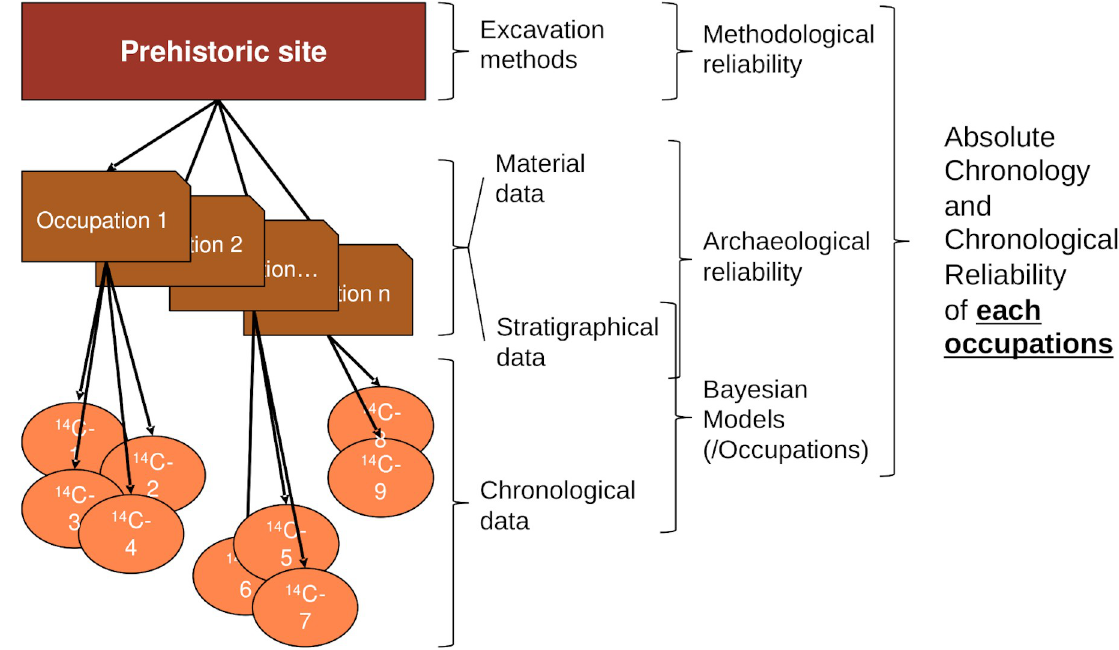
Fig 3. Method to situate in time the occupations of a site. Methodological principles allowing us to situate the occupation(s) of a site over time and to estimate the reliability of the data.